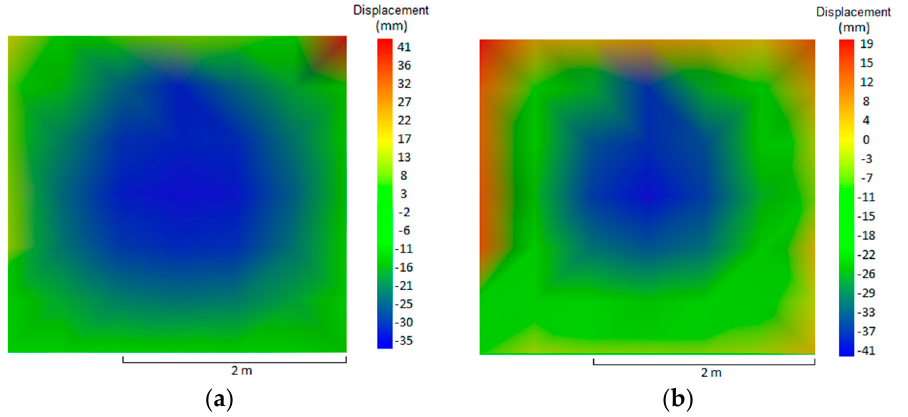
Figure 7. Displacement of the plane at ( a ) 30 min—W1 and ( b ) 150 min—W1.